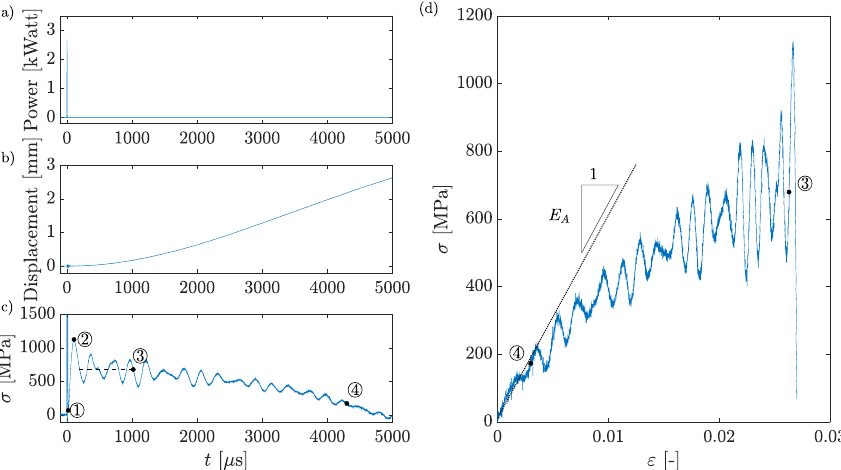
Figure 4. Typical results of experiments in the clamp-free configuration of NiTi wires. The wire diameter was 0.38 mm and its length 93 mm, its free end was attached to a mass large enough to keep it aligned prior to actuation. ( a ) Heating pulse of electric power transferred to the wire. (A zoomed-in view of the shape of the electric pulse is presented in the top panel of Figure 6.) ( b ) Displacement measurements taken at the bottom end of the mass. ( c ) Stress evolution in the wire. Points 1 (cid:13) – 4 (cid:13) signify the dead time of the wire, peak stress, onset of stress decrease in the wire, and the end of the transformation, respectively. The dashed line represents the equilibrium stress averaged over the first 1000 µ s. ( d ) Stress-strain curve plotted based on the data from figures ( b , c ). Points 3 (cid:13) and 4 (cid:13) are the same as in ( c ). The linear dotted line has a slope equal to the elastic modulus of austenite, E A , signifying the elastic relaxation of the austenitic wire at the end of the